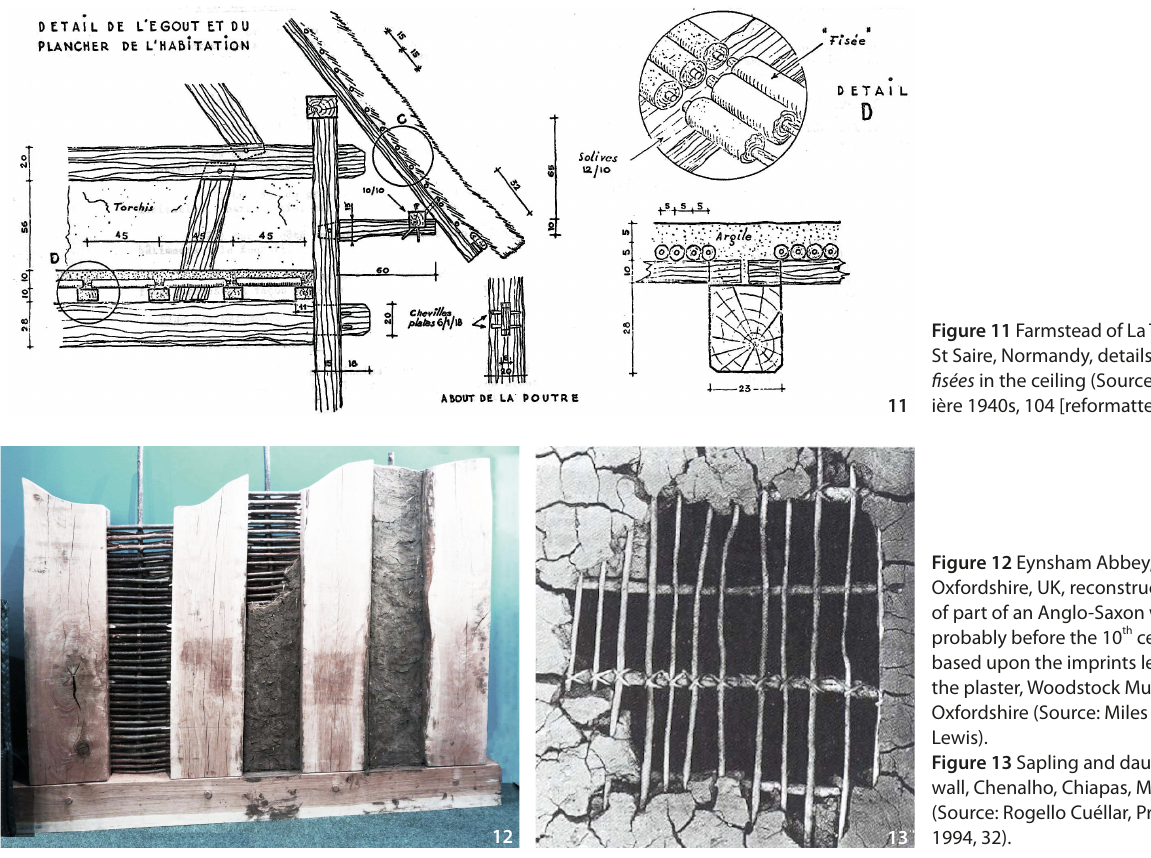
Figure 12 Eynsham Abbey, Oxfordshire, UK, reconstruction of part of an Anglo-Saxon wall, probably before the 10 th century, based upon the imprints left in the plaster, Woodstock Museum, Oxfordshire (Source: Miles Lewis). Figure 13 Sapling and daub wall, Chenalho, Chiapas, Mexico (Source: Rogello Cuéllar, Prieto 1994, 32).